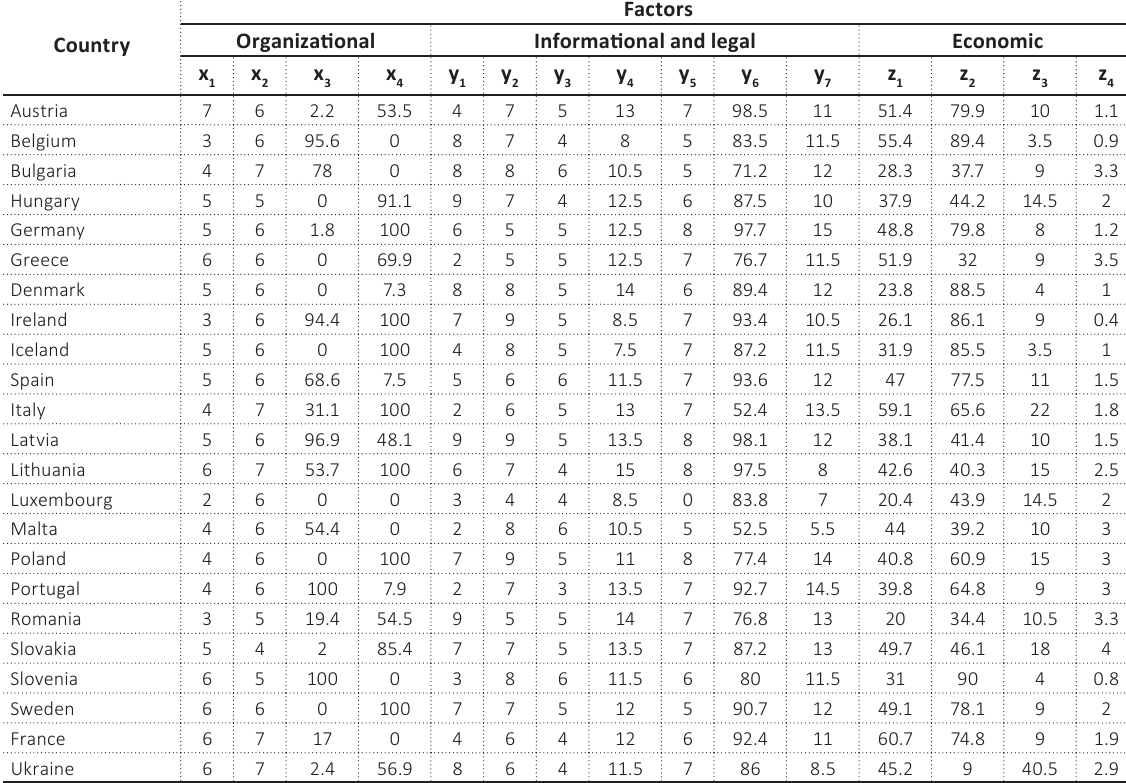
Table 3. Output data for modeling the level of prevention of corporate bankruptcies (D)